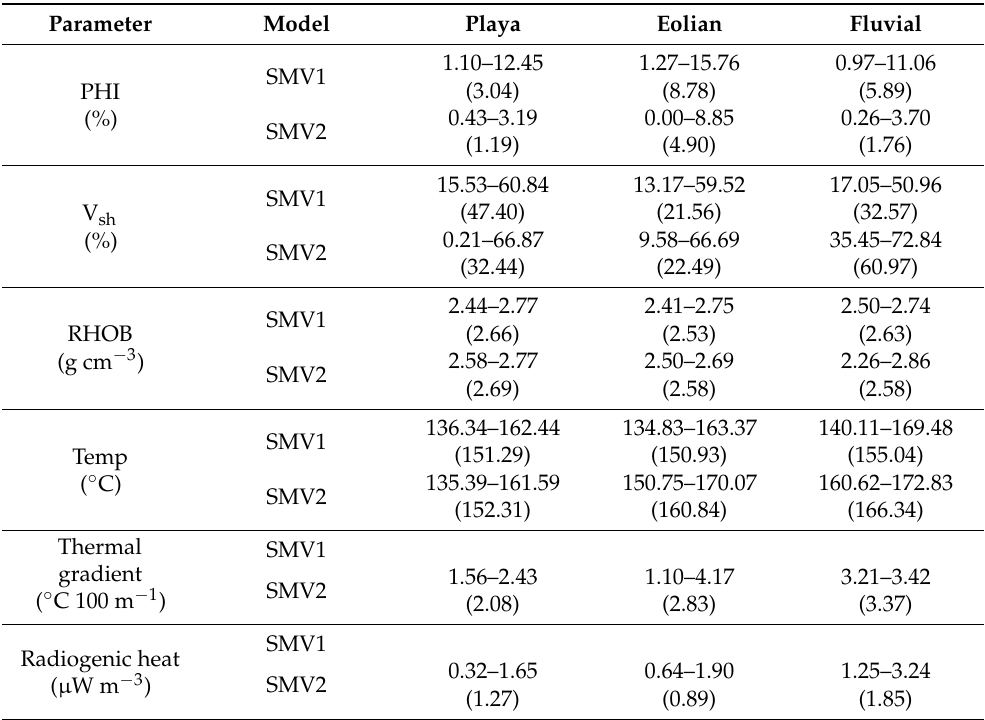
Table 5. Basic statistics of modeled parameters derived from models in variants SMV1 and SMV2 (min–max,